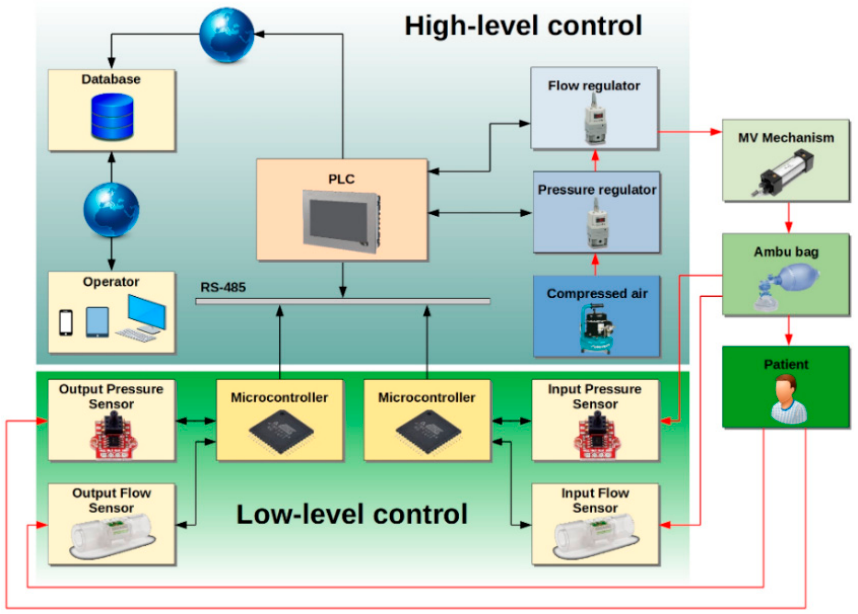
Figure 4. Control system of the mechanical ventilator BreaThU.